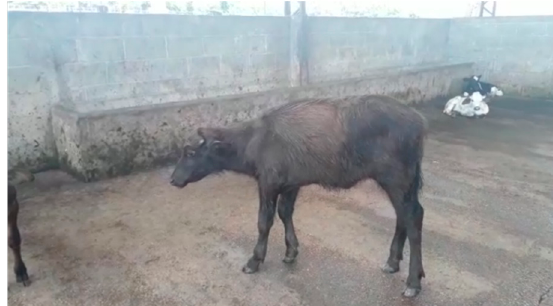
Figure 11. Animal behavior immediately after surgery (time 0). Animal under observation until ready for re ‐ establishment.